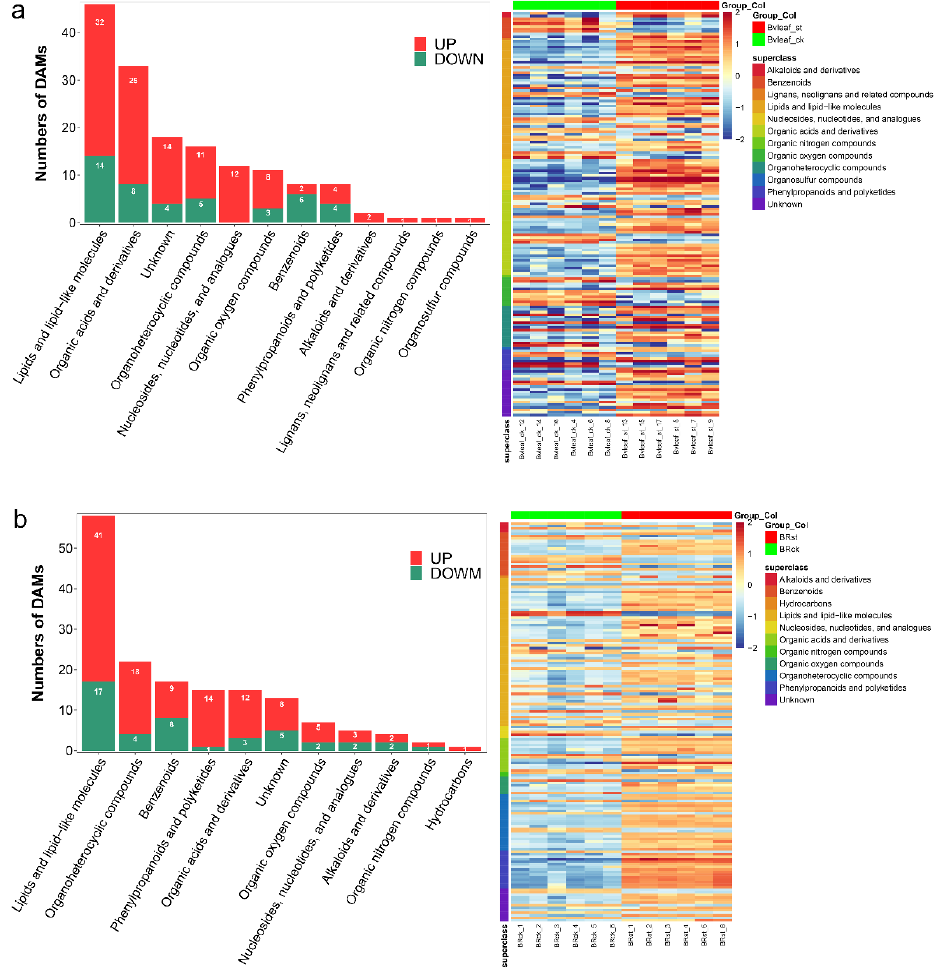
Figure 8. Differentially accumulated metabolites under salt treatment in sugar beet. ( a ) leaf. ( b ) root. Six independent replicates of each stage are also displayed in the heat map.